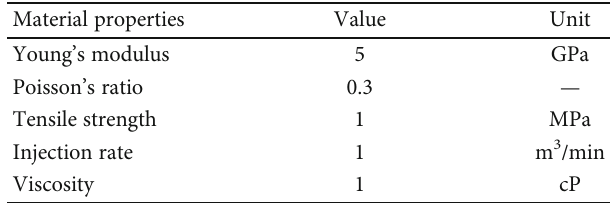
Figure 10: Geometric model for simulation of hydraulic fracturing in combination with hydraulic slots. Table 2: Parameters used in the simulation of fi eld-scale hydraulic fracture propagation with a preset